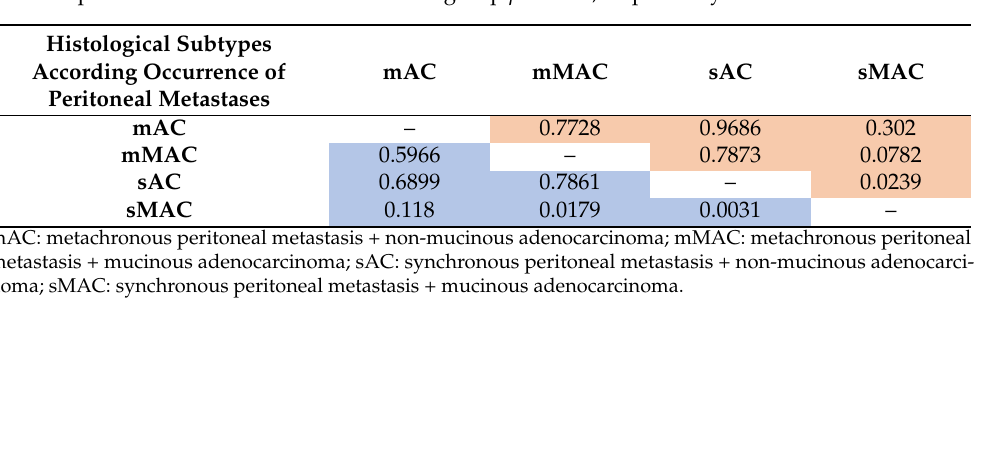
Table 5. Comparison of the survival of the four study groups. The orange and blue sections show the disease-specific and overall survival between-group p -values,